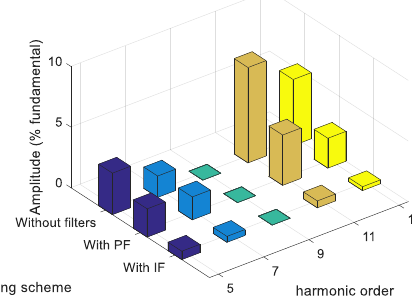
Figure 9. Grid current spectra.